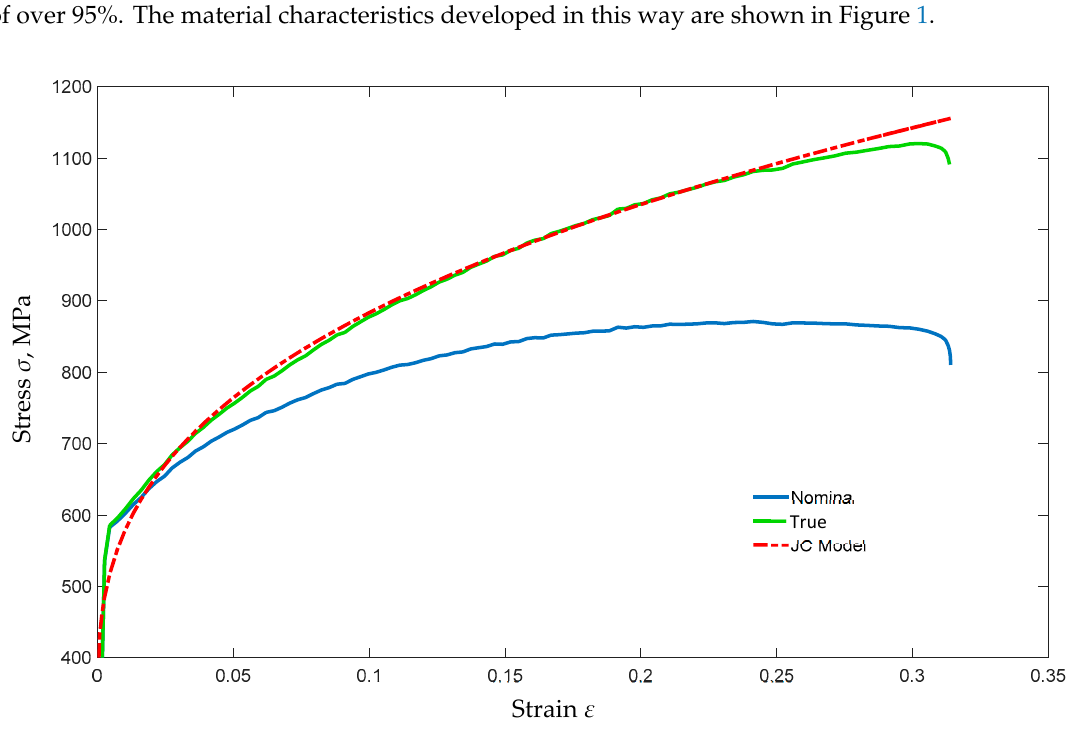
Figure 1. Comparison of the results of a static tensile test and program generated Johnoson-Cook model.